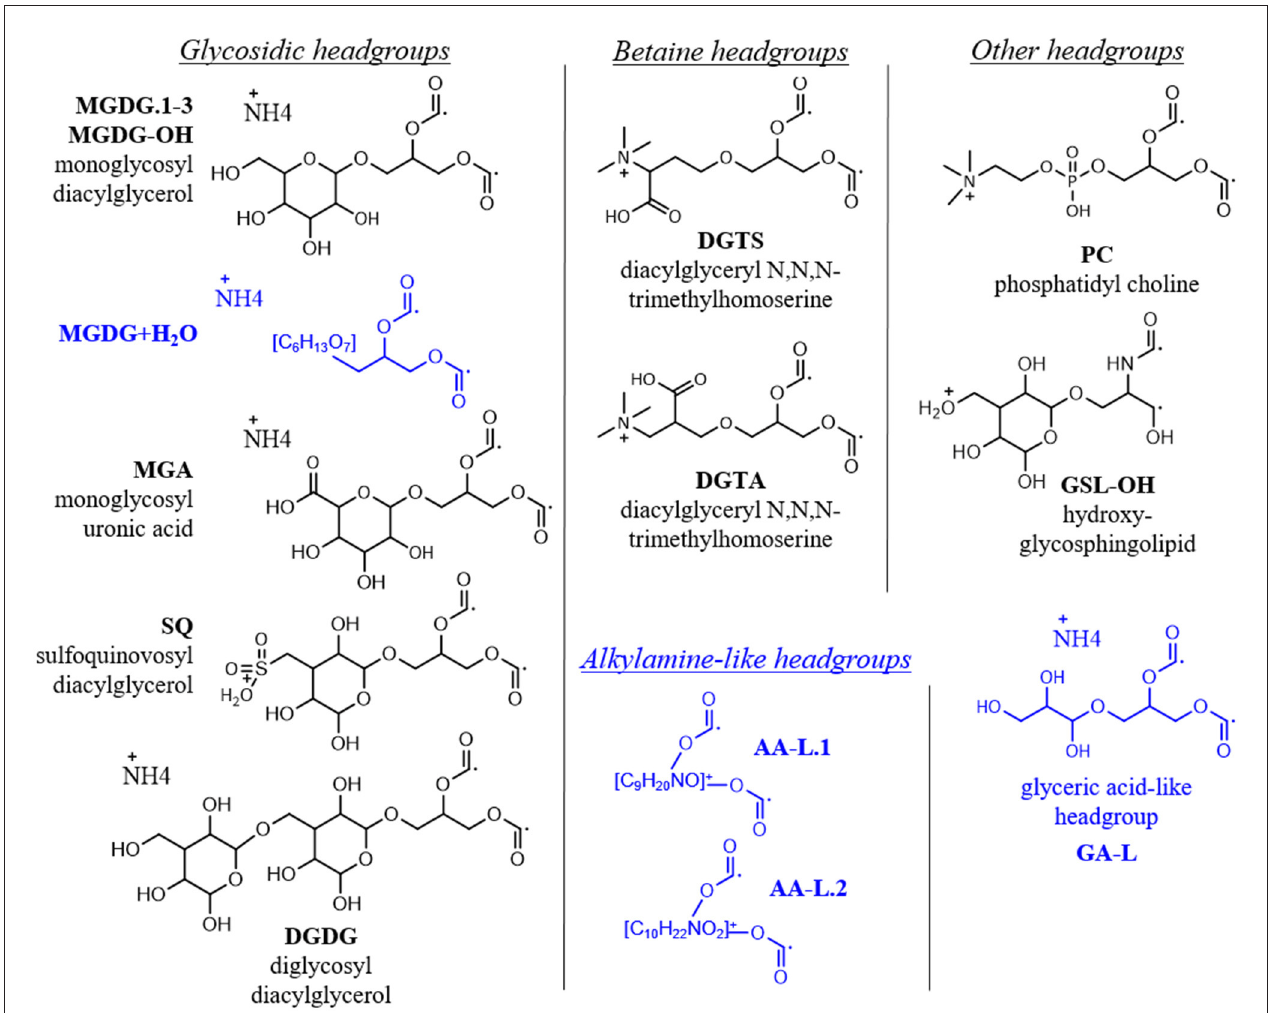
FIGURE 2 | IPL headgroups in oligotrophic ocean mesocosms. Depicted are the adducts of the headgroup and glycerol moieties with radical ions in place of alkyl chains, corresponding to their elemental formulae used for high resolution MS identification (i.e., CxHxNxOx; cf. Table 1 ). Putative structures of novel headgroups identified during this study are shown in blue. MS2 spectra for novel headgroups are provided in Figures S2–S6 and described in Text